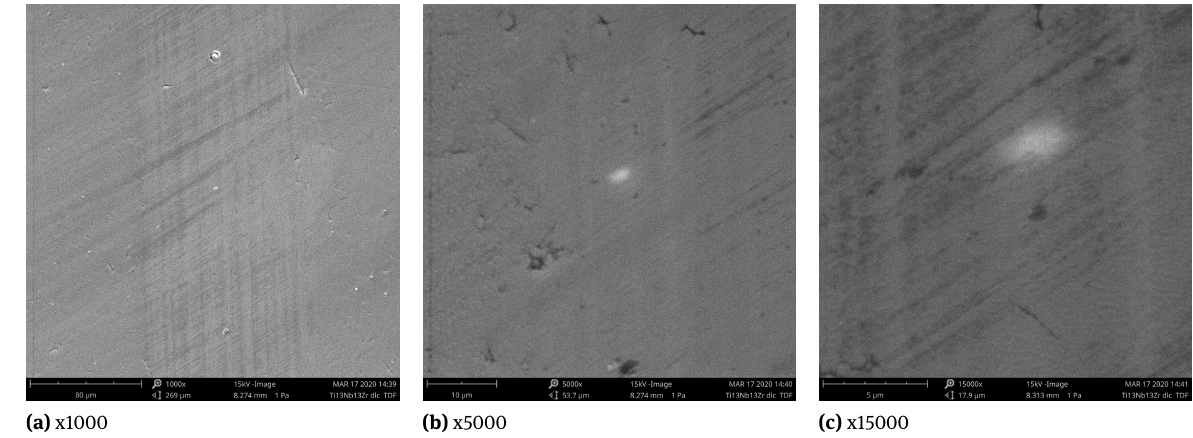
Figure 11: Surface morphology of the wear traces after techncal dry friction (TDF) for Ti13Nb13Zr a-C:H